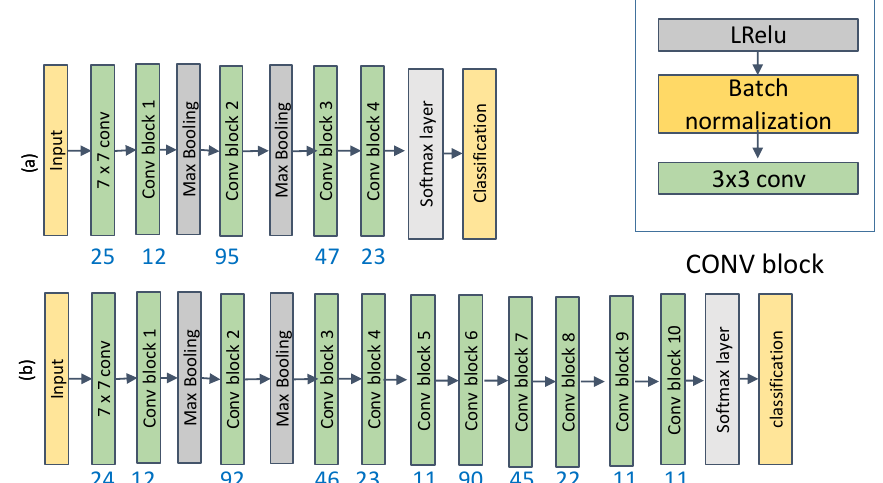
Figure 3. ( a ) FVC2004 FKTNET architecture. ( b ) Fingerprint FKTNET architecture.